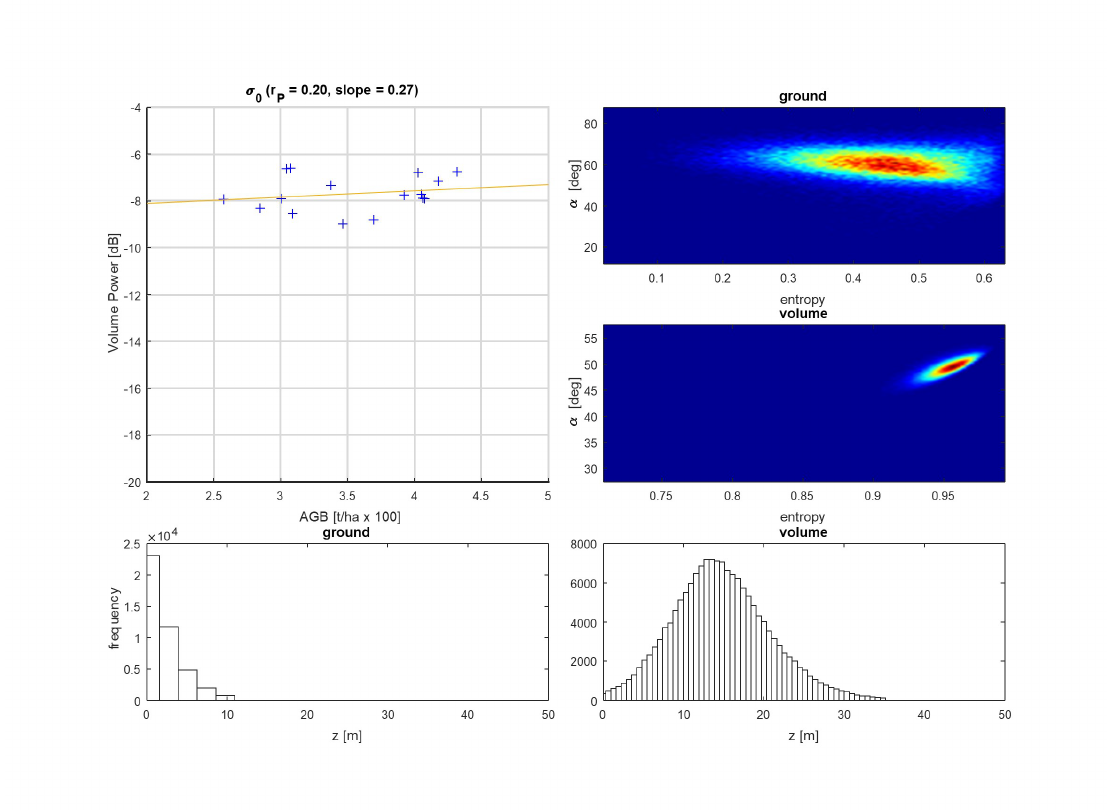
Figure 4. Outer/Inner Solution. Top left: scatterplot between in-situ AGB and volume backscattering. Top right: analysis of ground and volume polarimetric signatures in the alpha/entropy plane. Bottom: histograms of the interferometric phase center of ground and volume scattering. Phase center is = (cid:54) γ g , v and k z is the interferometric wavenumber corresponding computed as ˆ z g , v = φ g , v / k z , with φ g , v int int to the selected baseline [16]. Data-set: Paracou,